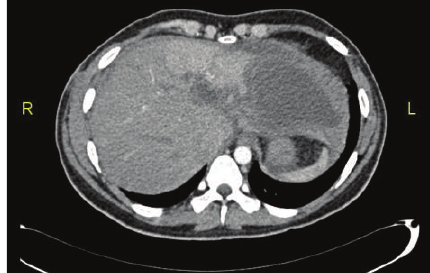
Figure4:Follow-upabdomenCT(after4weeksoftheTAE)showed start of liver regeneration and resolution of left lobe cystic changes.